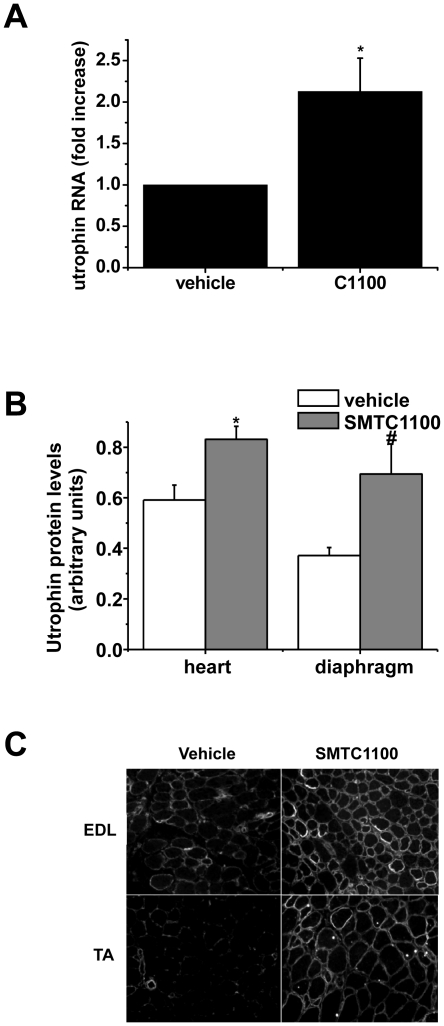
Effect of SMT C1100 on in vivo utrophin levels in
the mdx mouse.(A) Two-fold increase in utrophin mRNA following daily oral
administration of mdx mice with SMT C1100 (50
mg/kg/day) or vehicle only (PBS-Tween-20 (0.1%)/5% DMSO)
from three weeks of age for four weeks. Results represent the mean
± S.E from six mice per treatment group and are corrected for
β-actin. *p = 0.019; (B) Utrophin protein
levels in heart and diaphragm following treatment of
mdx mice as described in (A) above. Blots were
stained with anti-utrophin (MANCHO3; 1∶100) and ECL HRP-conjugated
anti-mouse antibody (GE Healthcare). Bands were quantified using Image J
and arbitrary units represent utrophin levels corrected for equal
loading by α-actinin immunostaining. Results represent a mean
±S.E from eight mice per treatment group except for heart vehicle
only which is based on n = 7. *p<0.01;
#p<0.05; (C) Immunohistochemical staining of EDL and TA muscle
sections (10 µm; 20× magnification) were prepared from
mdx mice treated as in (A). Sections were stained
with anti-utrophin polyclonal antibody URD40 (1∶100) and
fluorescein isothiocyanate-conjugated anti-rabbit secondary antibody
(1∶1000).